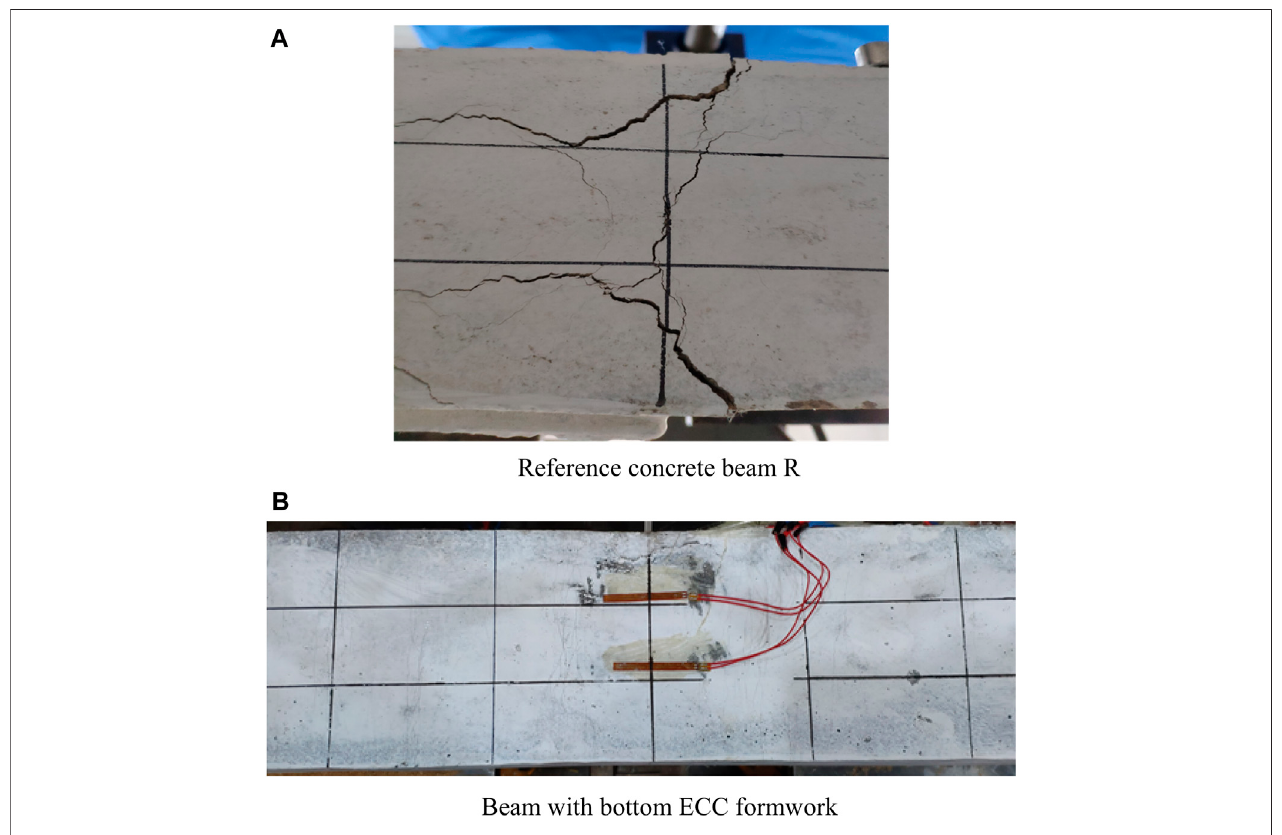
FIGURE 5 | Comparison of the crack distribution in the bottom of the beam.